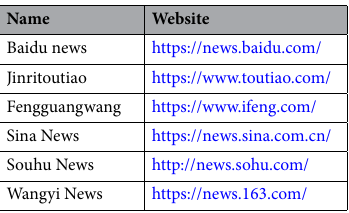
Table 1. The online news data source used in the